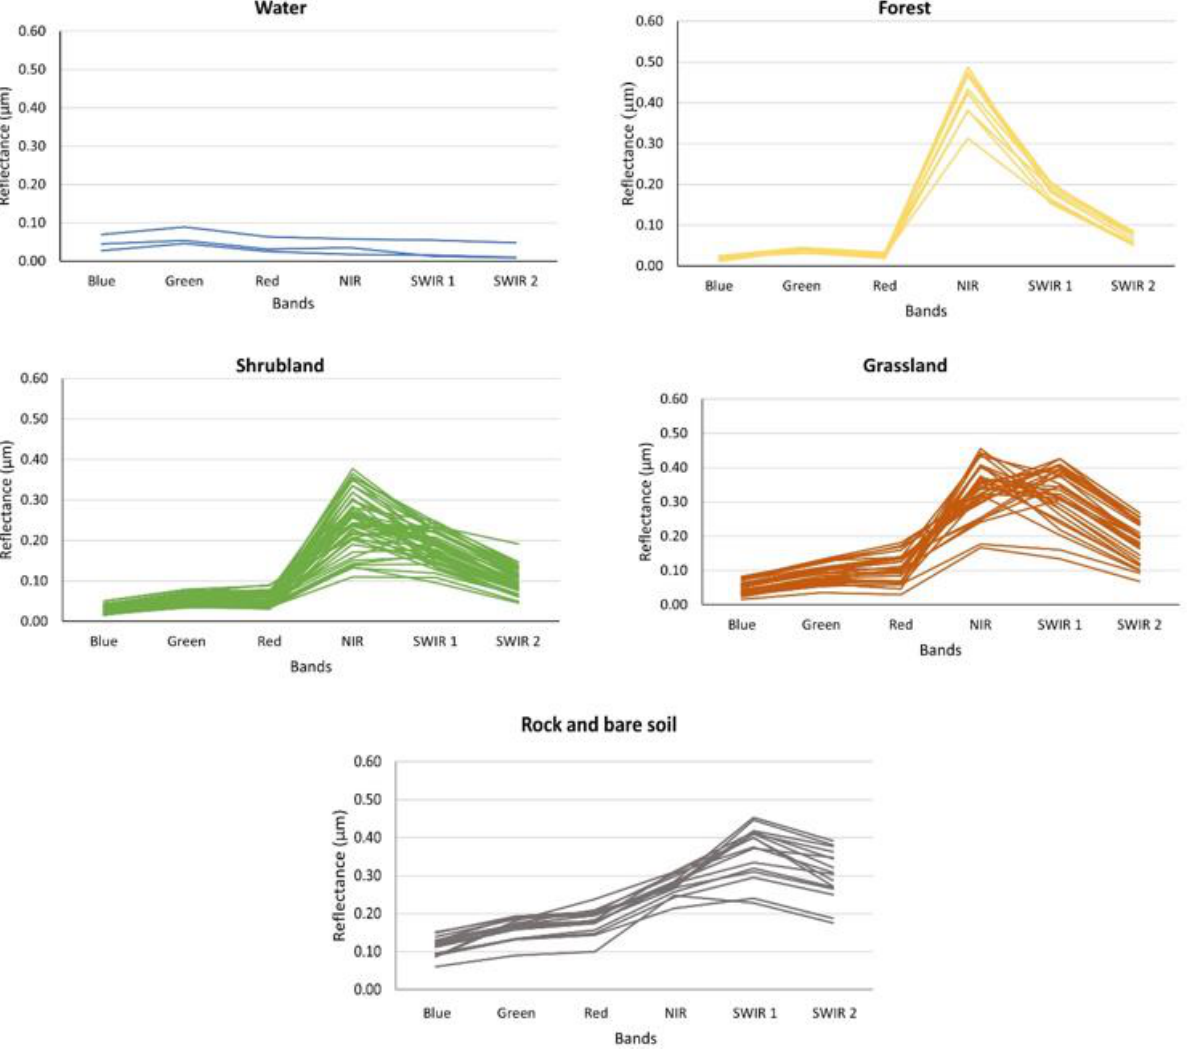
Figure 6. Spectral signatures included in the optimized libraries (L1_IES, L2_IES, L3_IES, L4_IES, 1990_IES, 2000_IES, 2010_IES, and 2020_IES) obtained after IES analysis (water: 3 endmembers; forest: 9 endmembers; shrubland: 48 endmembers; grassland: 31 endmembers; rock and bare soil: 16 endmembers).